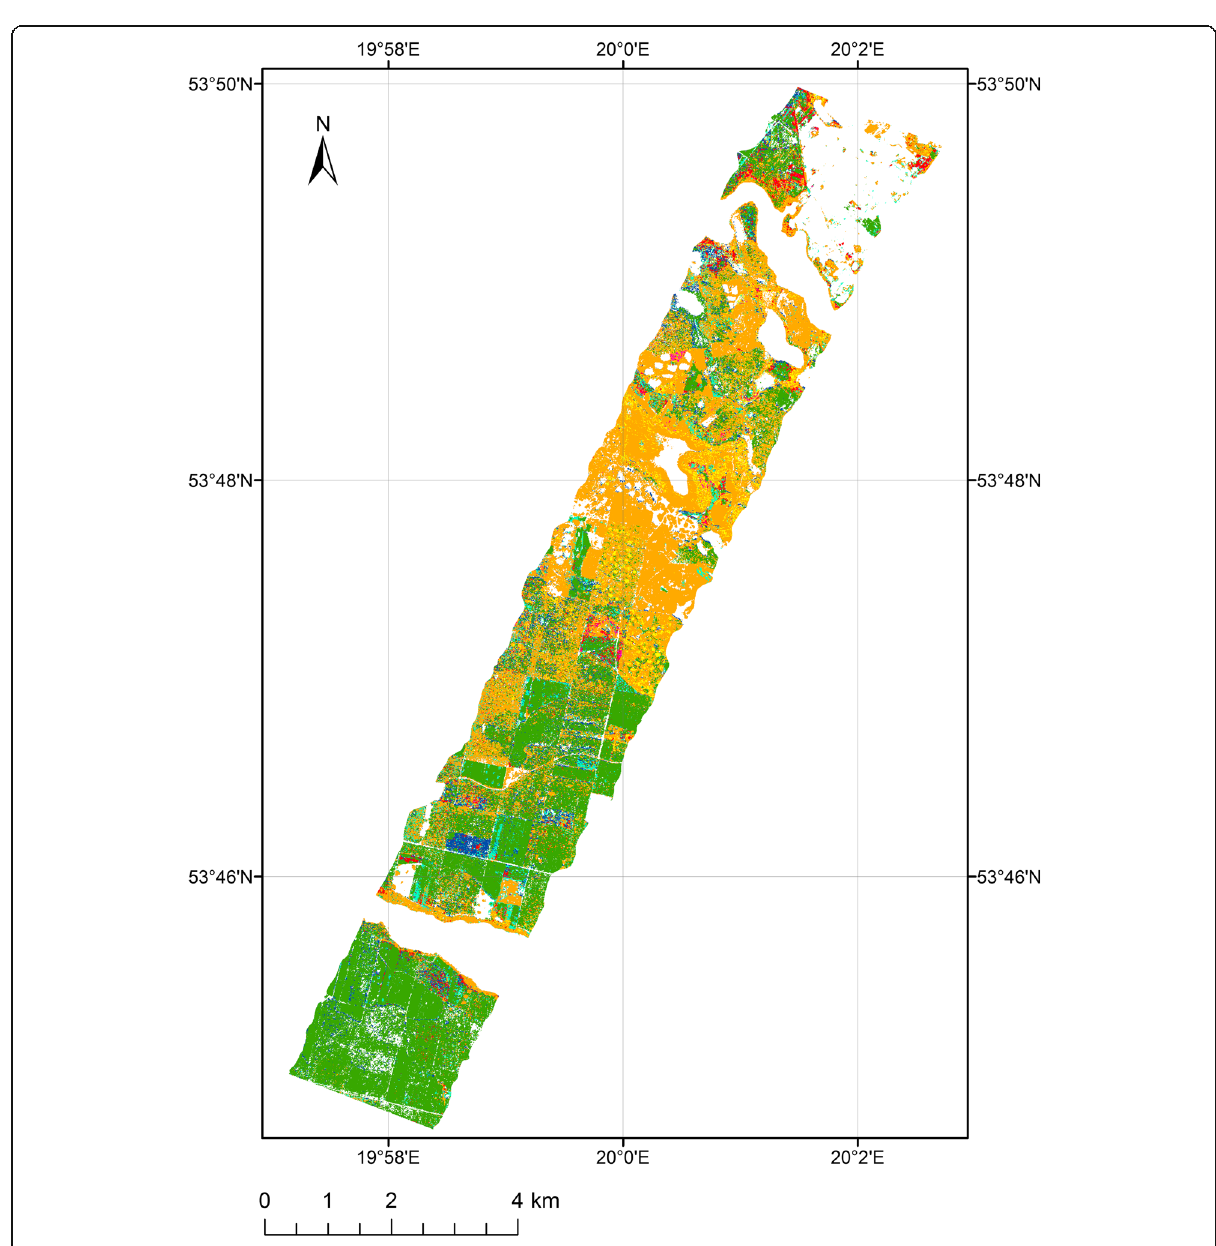
Fig. 3 Classification results (maximum likelihood on seven minimum noise fraction bands). Legend: red — birch, orange — European beech, yellow — oak, pink — hornbeam, pale blue — European larch, green — Scots pine, dark blue — Norway